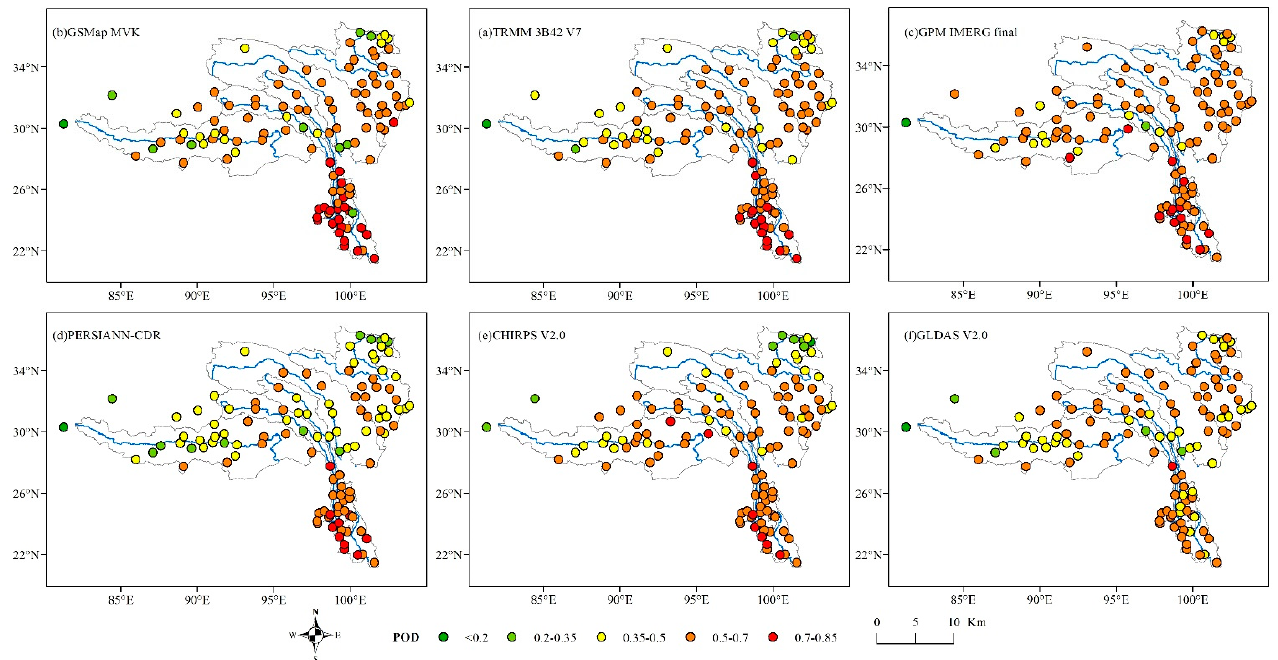
Figure 8. The MAE between different rain gauges and corresponding grids in data products.